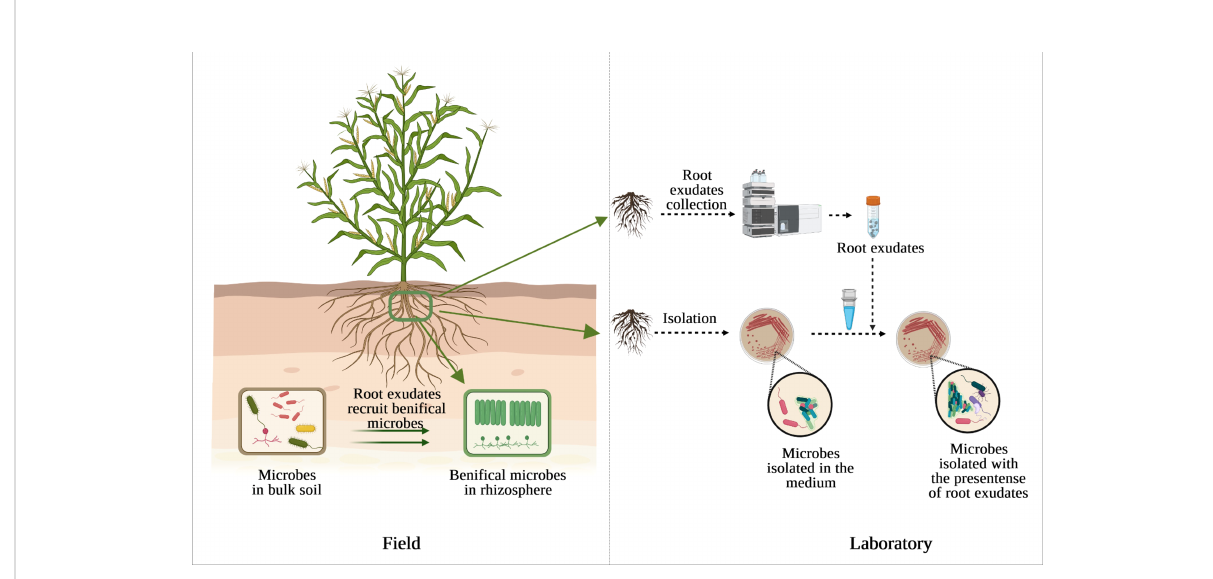
FIGURE 1 The presence of root exudates affects the diversity and abundance of bene fi cial microbes in the rhizosphere compared to bulk soil (left) and could also affect culturable microbes under laboratory condition